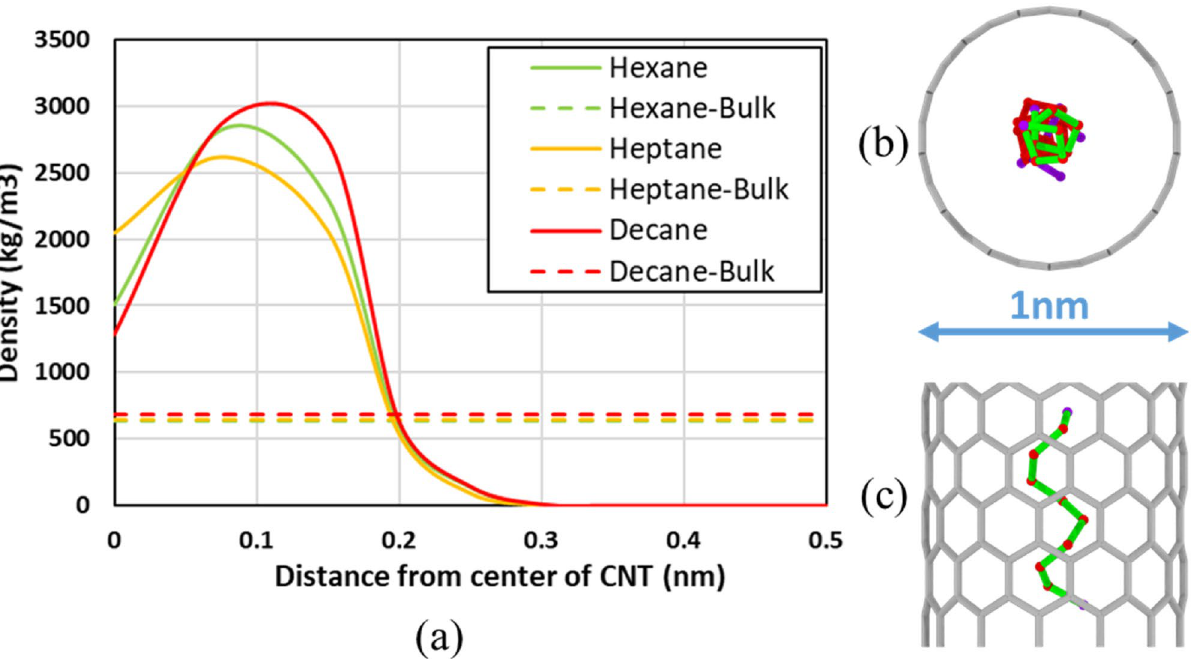
Figure 2. ( a ) Effect of confinement on the cross-sectional local density of fluids under confinement compared to the bulk density for 1 nm diameter CNT at 1 atm. ( b ) Cross-section of decane (carbon chain only) in 1 nm CNT, and ( c ) side view of decane (carbon chain only) in 1 nm CNT. Red represents carbon, and Purple represents terminal carbon for the given Decane molecule. The green color represents the highlighted molecule from two different perspectives. Created using OVITO (ver:3.3.0).